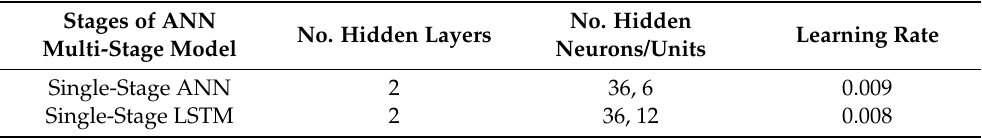
Table 5. Traditional ANN and LSTM Models Design Parameters. The loss metric Mean Absolute Error (MAE) was calculated using (12).